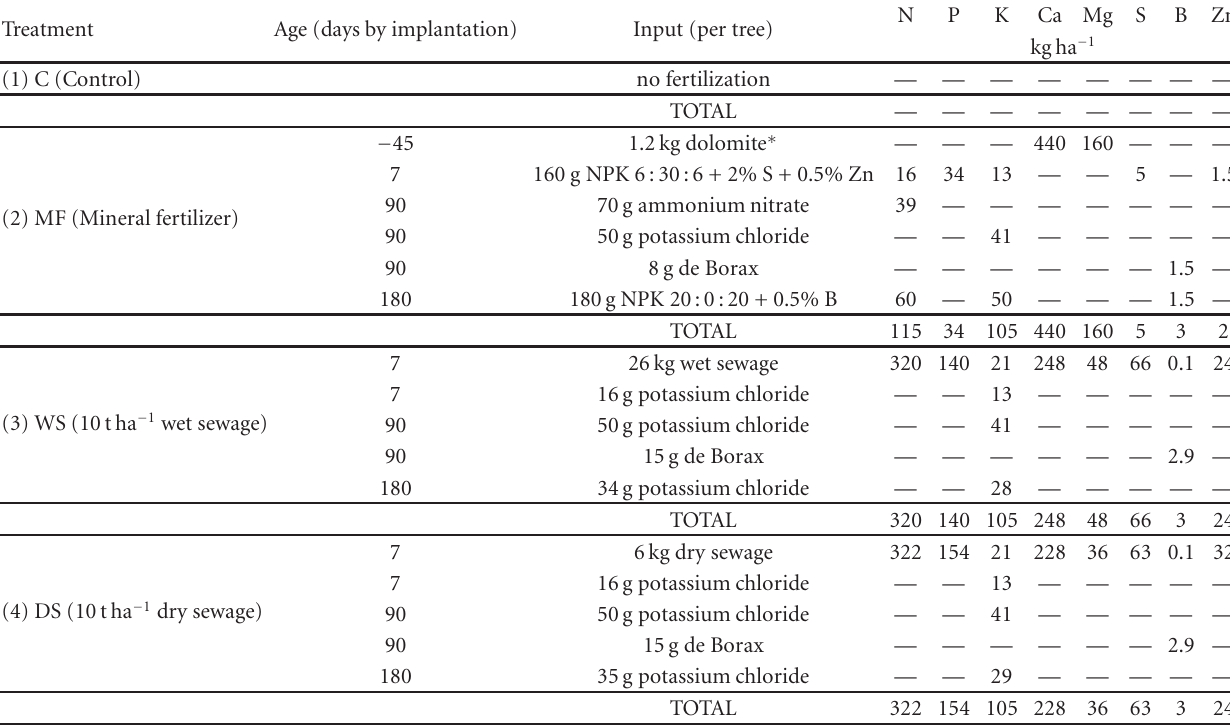
Table 3: Nutrients added in the treatments through the sewage sludge and mineral fertilizer application to the soil of the experimental forest